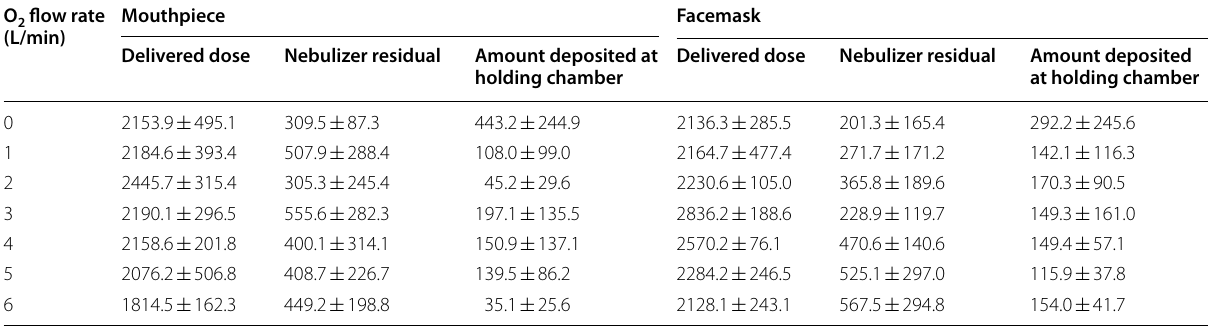
Table 1 Comparison between supplied doses of salbutamol and the inhalation filter in micrograms at different oxygen flow in L/min using mouthpiece and